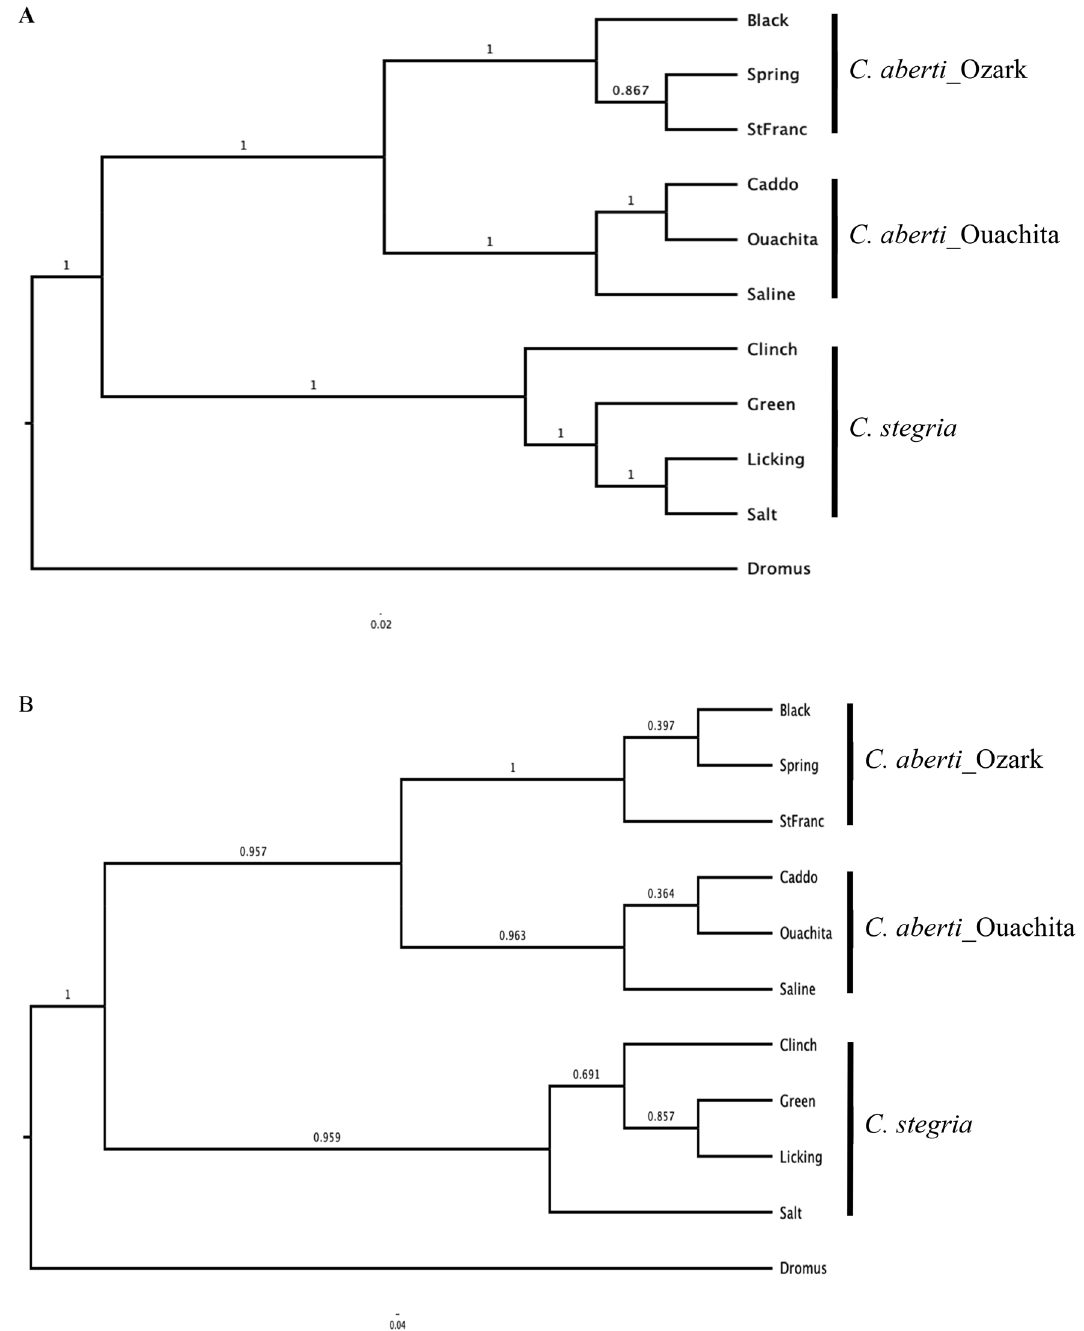
Figure 4. Species trees generated with Maximum clade credibility (MCC) and Median heights option in TreeAnnotator and with Transform branches (proportional) option in FigTree. Posterior probabilities are shown on the branch of each node. Total of 40 samples for 10 sampling sites (four samples per each sampling site) for Cyprogenia species were aligned and selected based on by selecting the individual samples with the highest coverage (smallest number of missing SNPs) ( A ) or by random sampling of individuals ( B ) using a custom Python